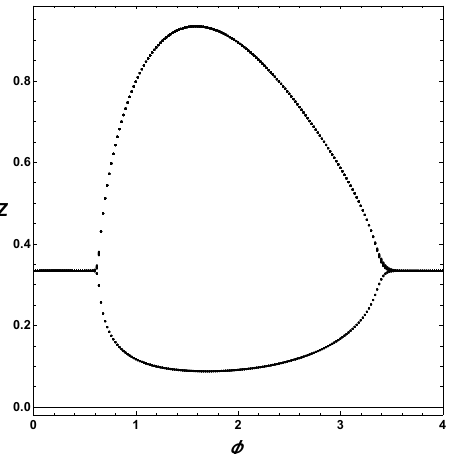
Figure 3. Poincare section of extrema for r = 0.40, K = 0.50, k u =